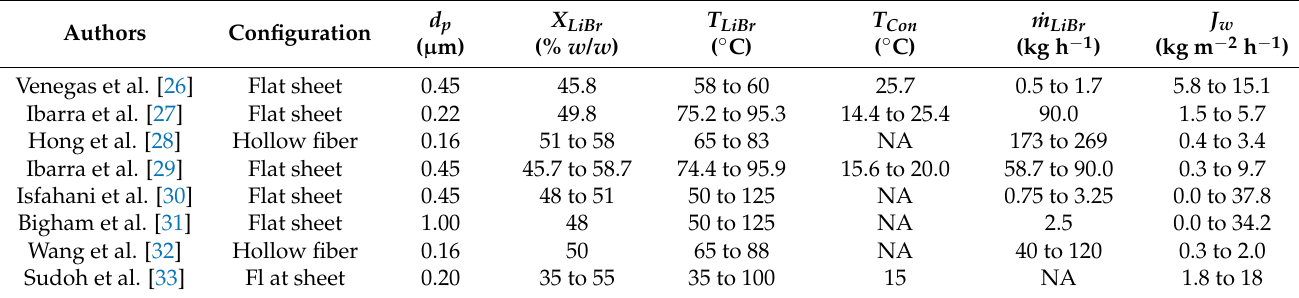
Table 1. Experimental operating conditions of the membrane-based desorbers reported in the